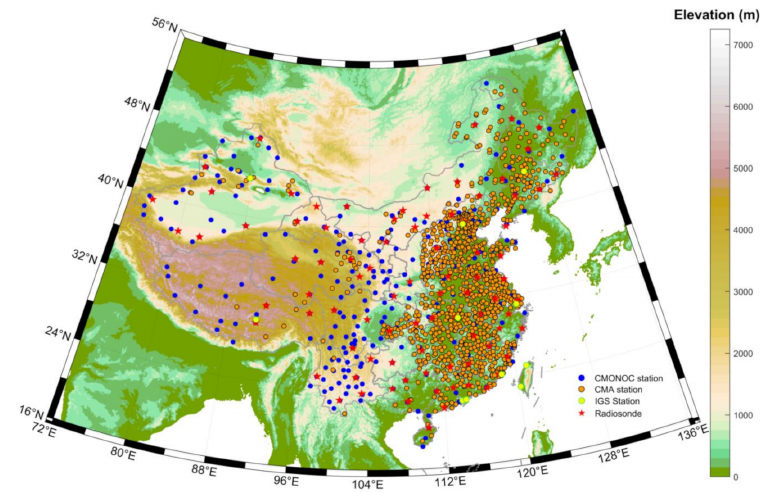
Figure 1. Research area and distribution of GNSS stations.